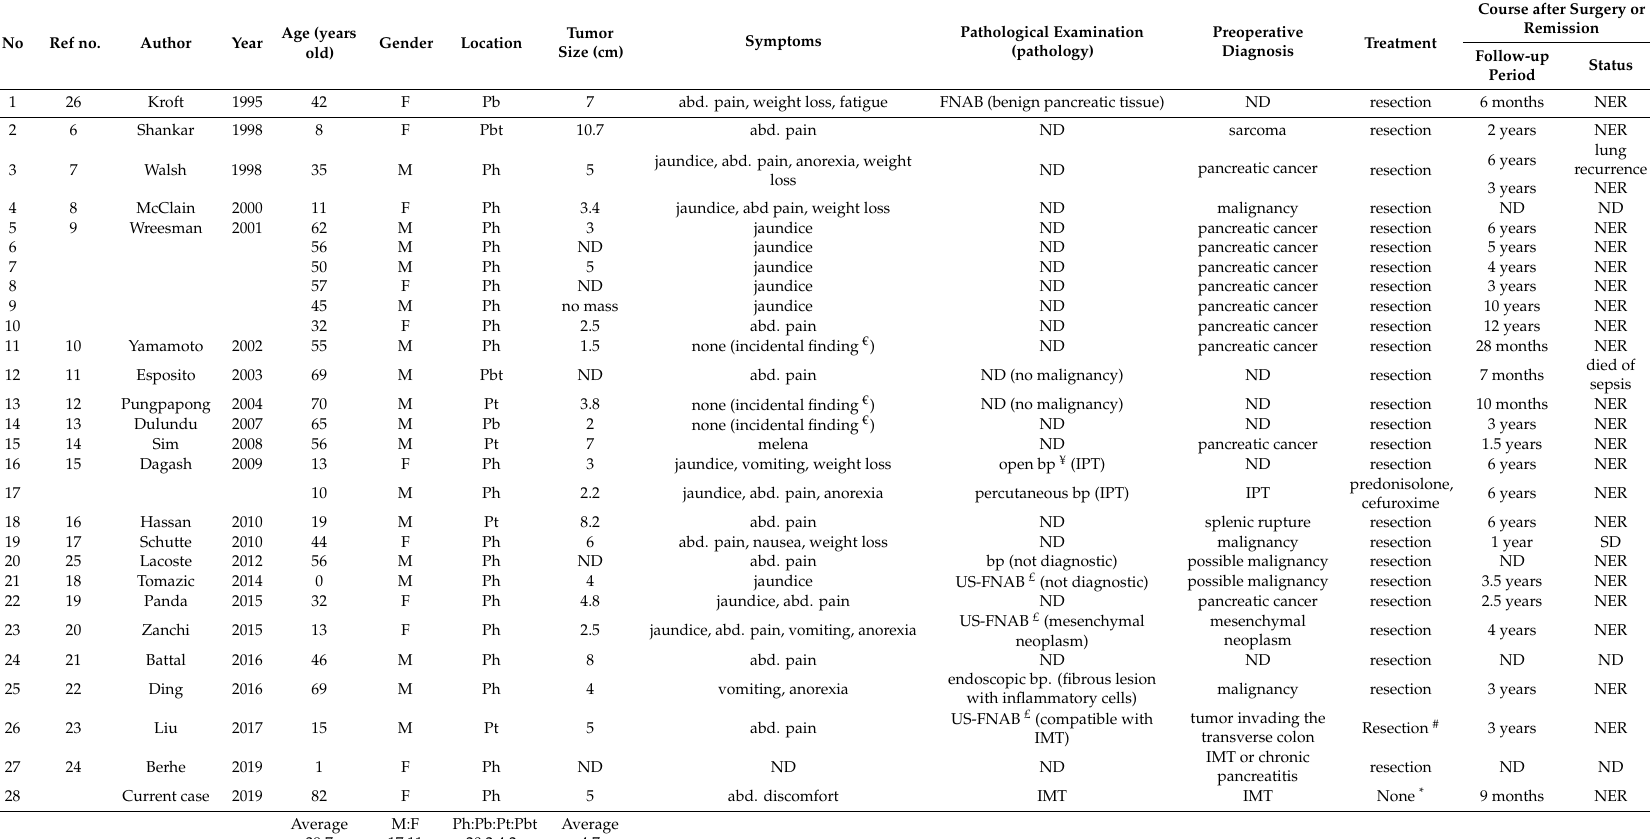
Table 1. Reported cases of inflammatory myofibroblastic tumor (IMT) of the pancreas (English